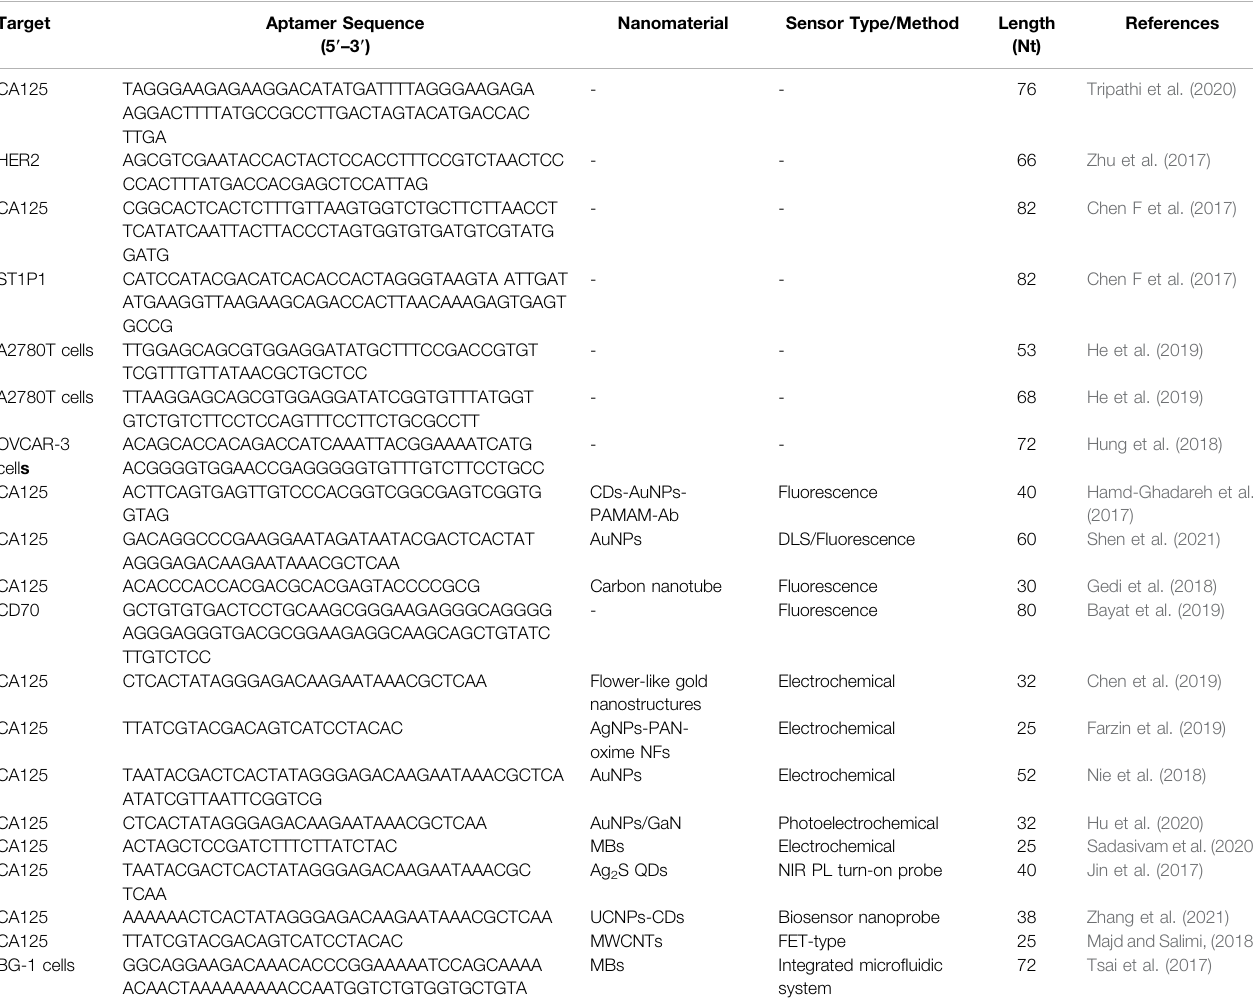
TABLE 1 | Applications of aptamers in the diagnosis of ovarian